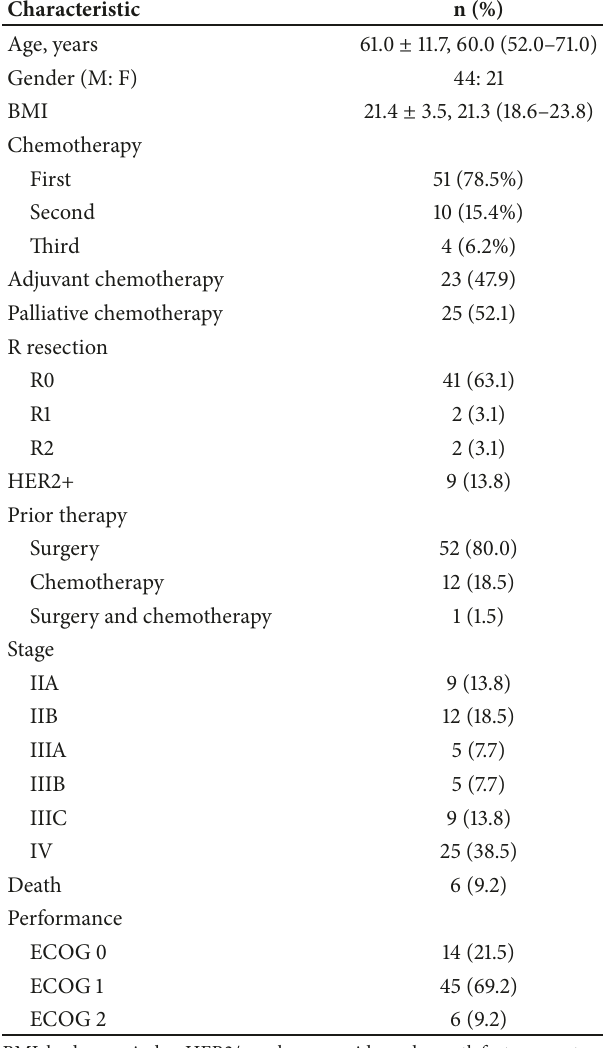
Table 1: Baseline characteristics of the patients with advanced gastric cancer (n =